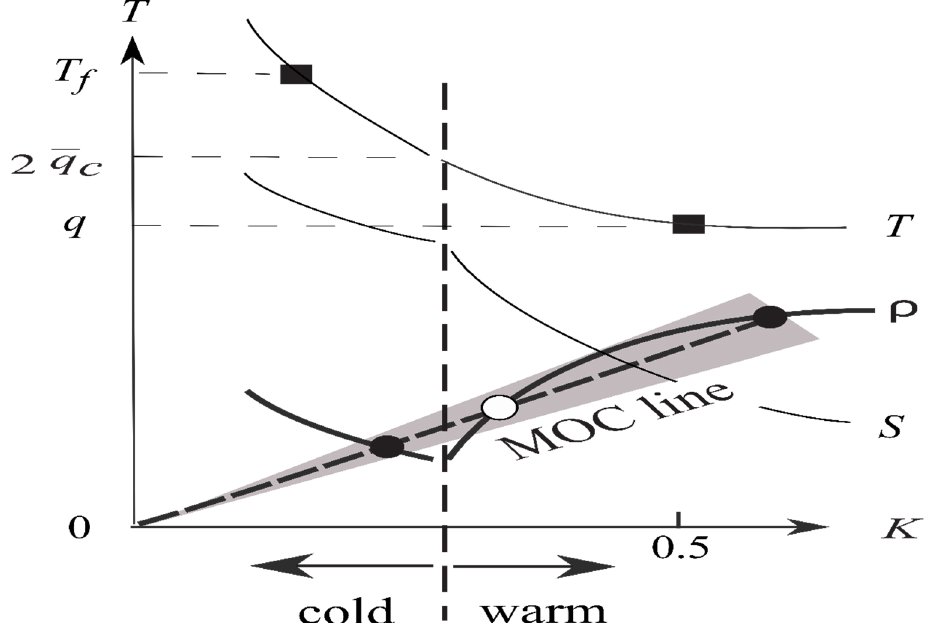
Figure 4. A schematic of the phase-space diagram in which subpolar temperature/salinity deficits ( T/S , thin solid lines) and density surplus ( 𝜌 , thick solid line) are plotted against MOC ( K ). The convective bound when the convective flux vanishes (vertical dashed line) divides warm/cold branches. The MOC line (sloping dashed line) pivots on the millennial timescale toward MEP (rectangles), whose intersect with the density curve specifies the climate state (solid ovals, the open oval being the unrealized saddle point). Markings on the ordinate pertain to the temperature. The density curve represents the spacing between temperature and salinity deficits (thin lines). The decreasing MOC would cool and freshen the subpolar water (hence the rising deficit lines) accompanied by a decreasing convective flux (not shown) hence an increasing atmospheric heat transport. The deficit in the convective flux from its global mean ( q ) is T /2, the factor 2 stemming from concurrent cooling of the surface air,